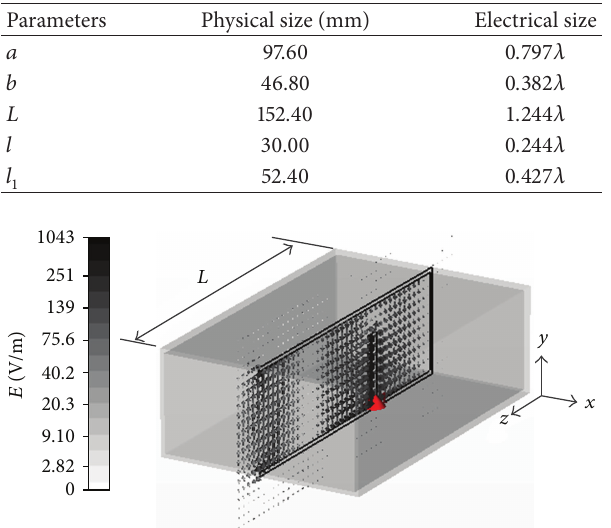
Figure 2: The simulated electric field distribution of the radiating section of the proposed antenna.